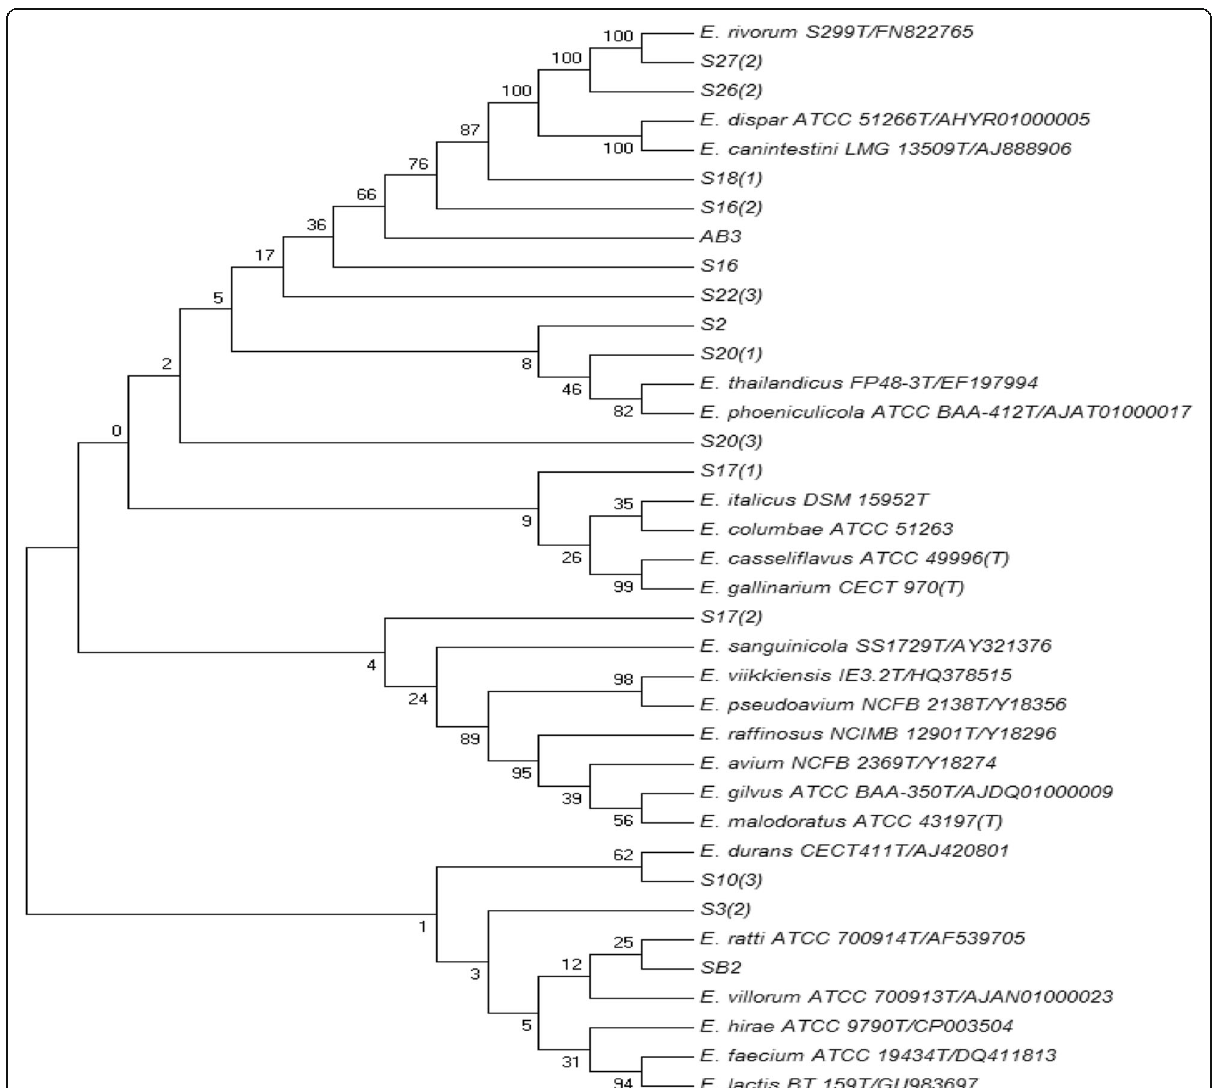
Fig. 1 Phylogenetic tree based on comparative analysis of 16S rDNA sequences showing relationship among isolates and other enterococcal